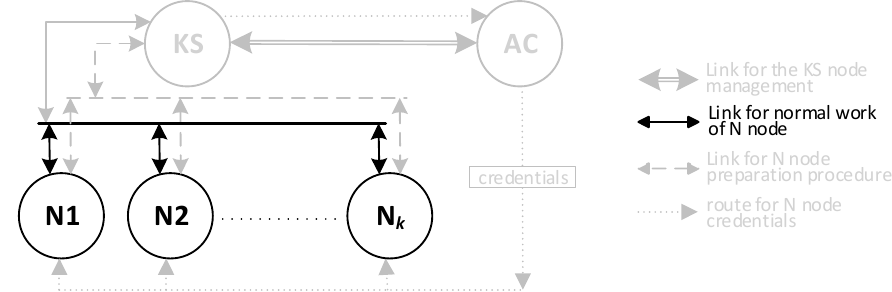
Figure 30. The way the N1 node and the N2 node work together during the data exchanging.